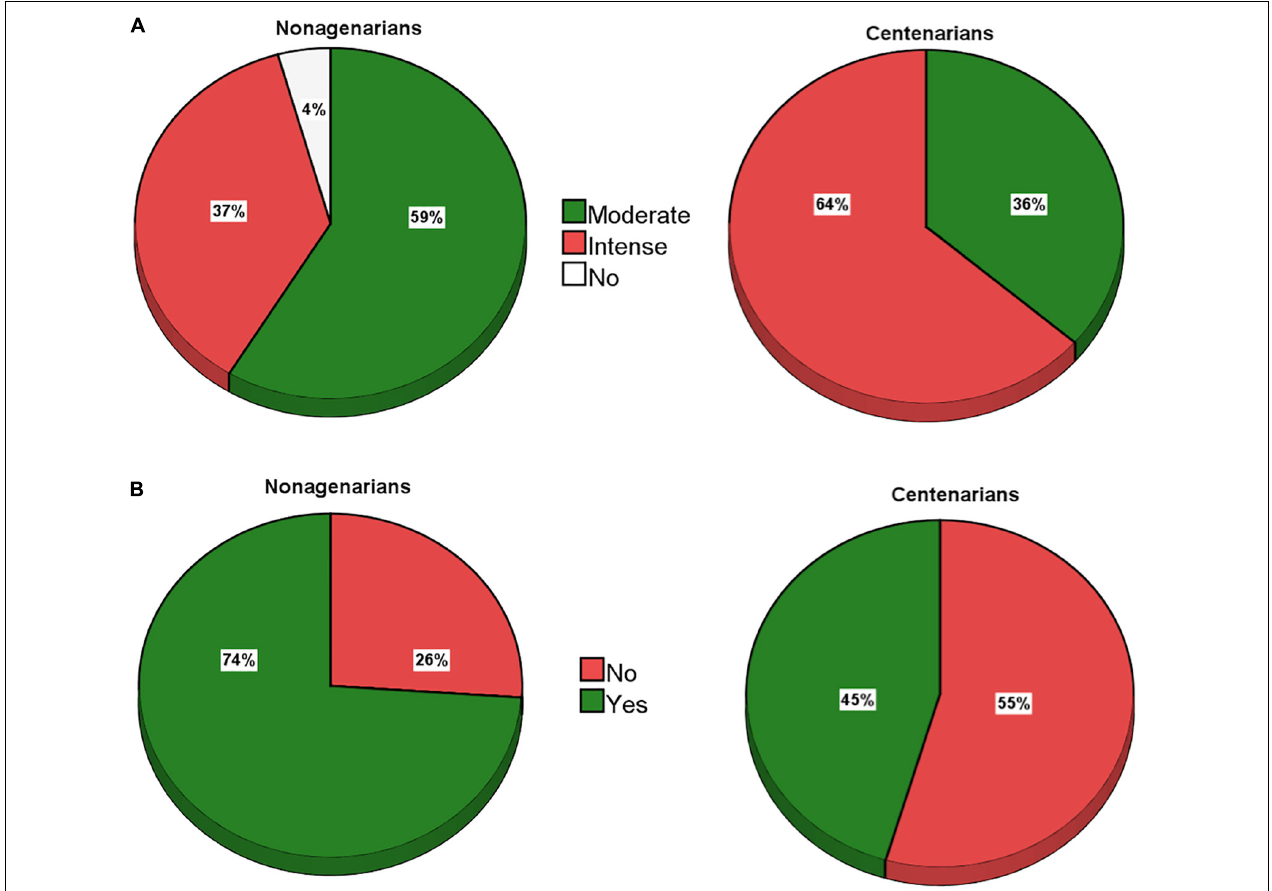
FIGURE 1 | Physical activity status of the study participants in their youth (A) and elderly (B)